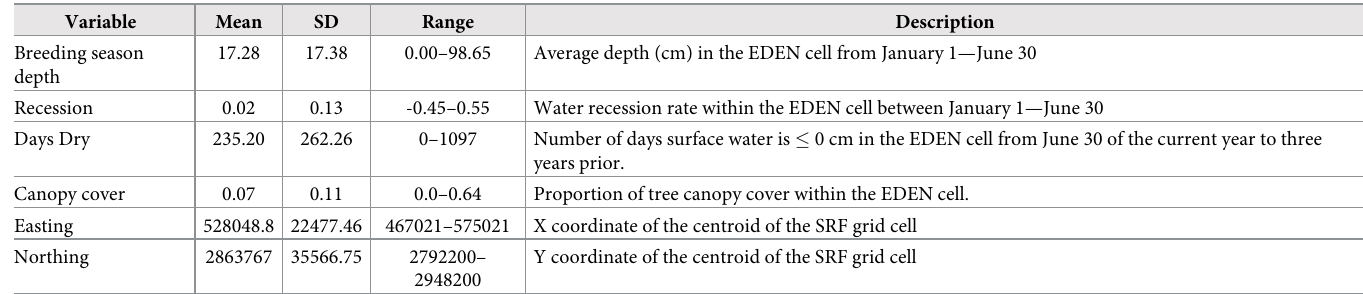
Table 1. Site covariates used for predicting species occupancy.